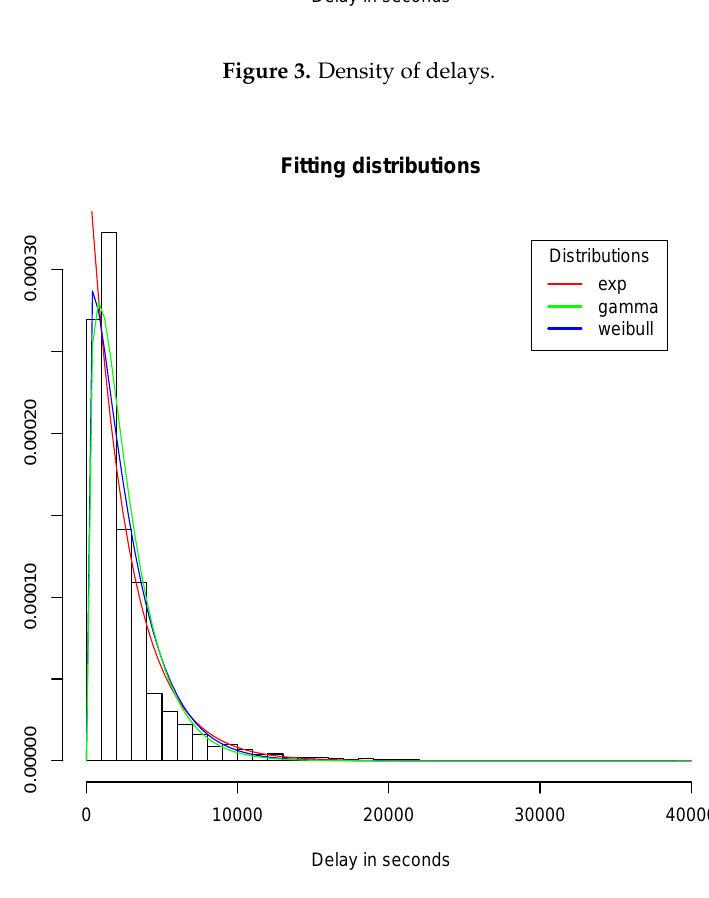
Figure 3. Density of delays.